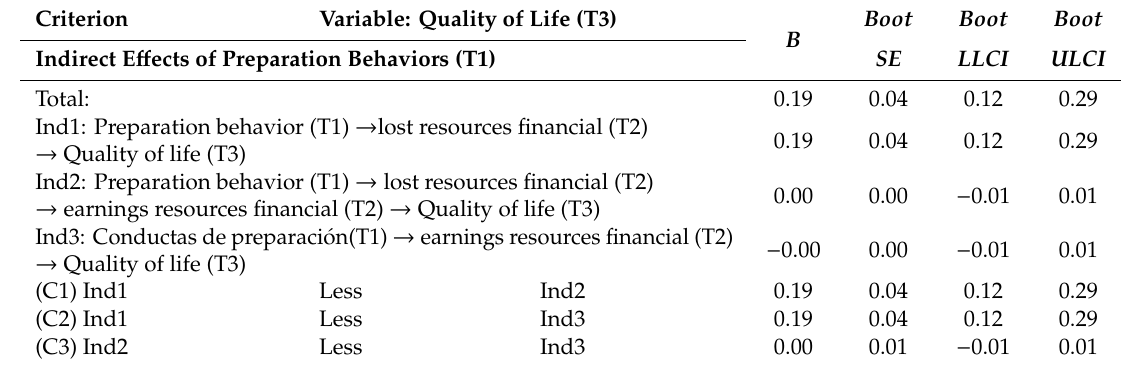
Table 5. Comparison of the indirect e ff ects of preparation behaviors (T1) through financial resource losses (T2) and gains (T2) in the prediction of quality of life (T3).